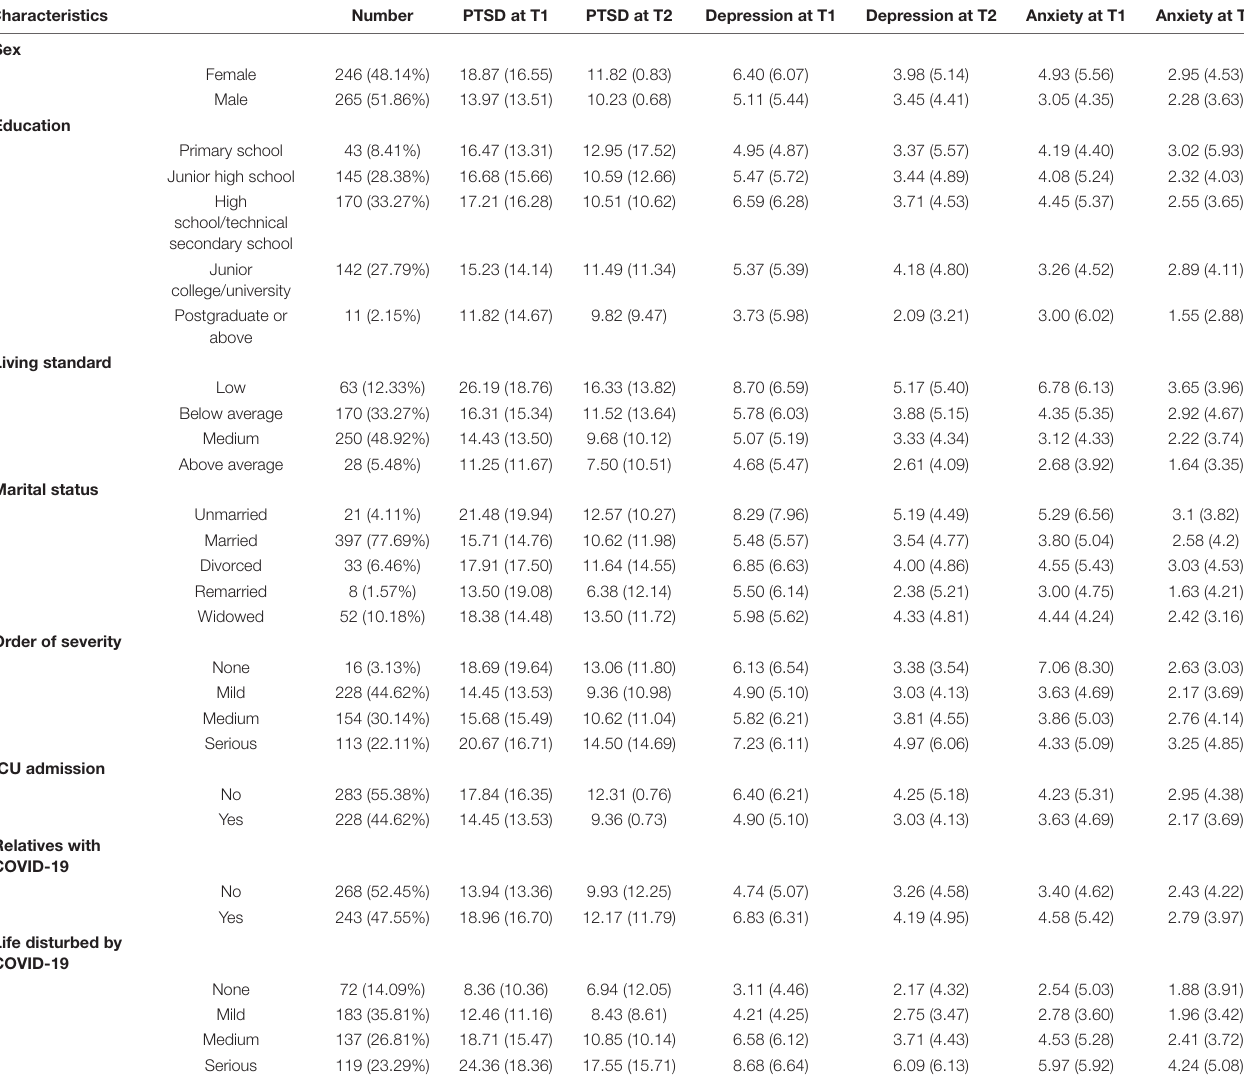
TABLE 2 | Sociodemographic characteristics and mental health of the participants.